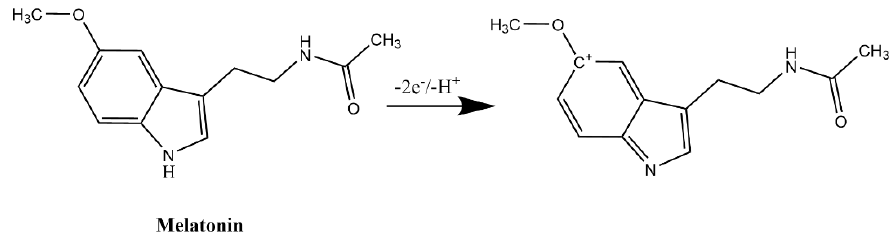
Scheme 3. The melatonin oxidation mechanism.